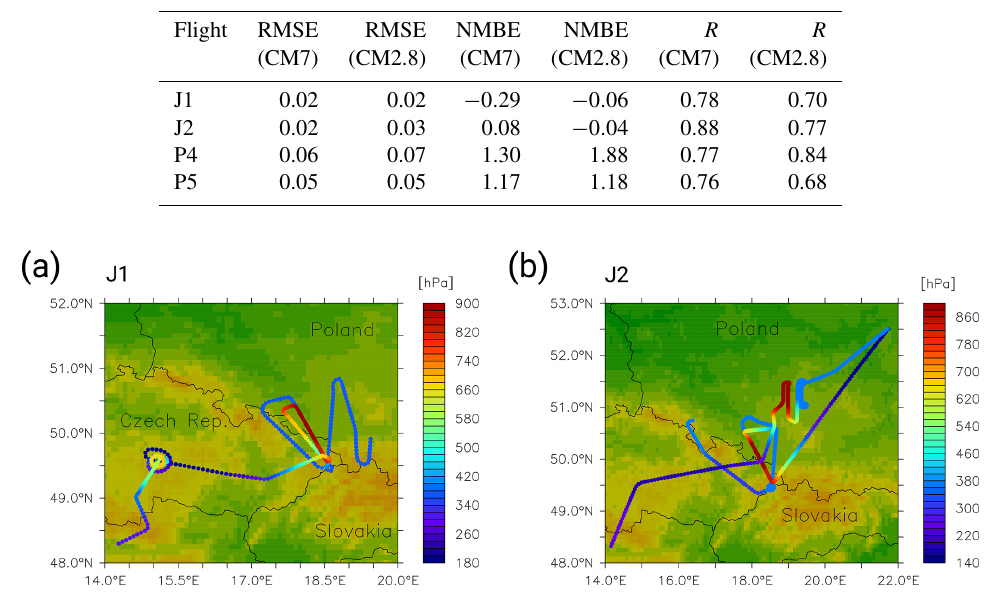
Figure 9. D-ADLR flight routes for J1 (a) and J2 (b) . The colour bar refers to the atmospheric pressure at flight level.